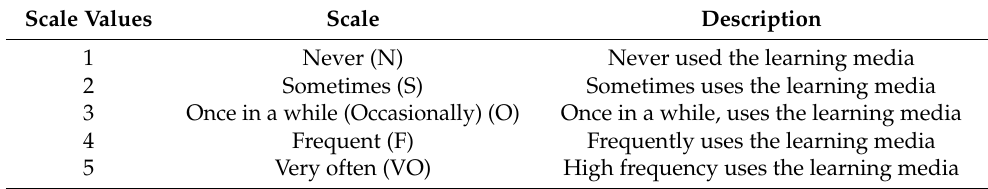
Table 3. Likert scales